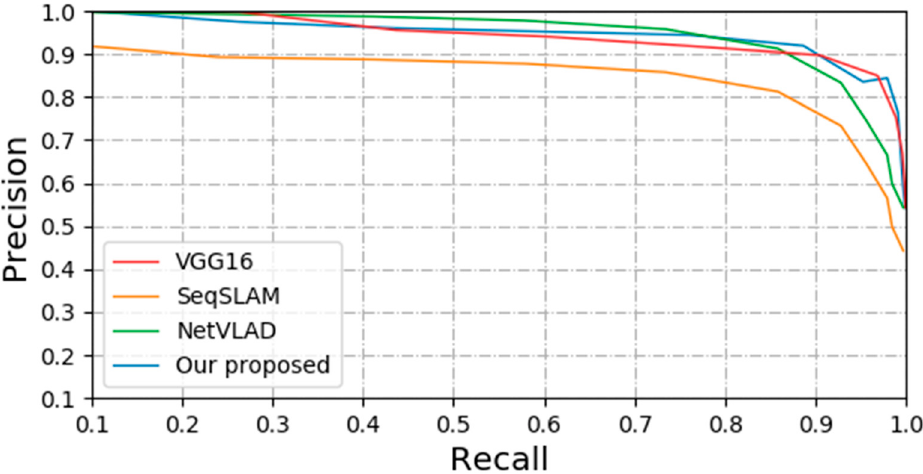
Figure 8. The performance comparison between our proposed method and the other three methods in the KTH-IDOL2 dataset.